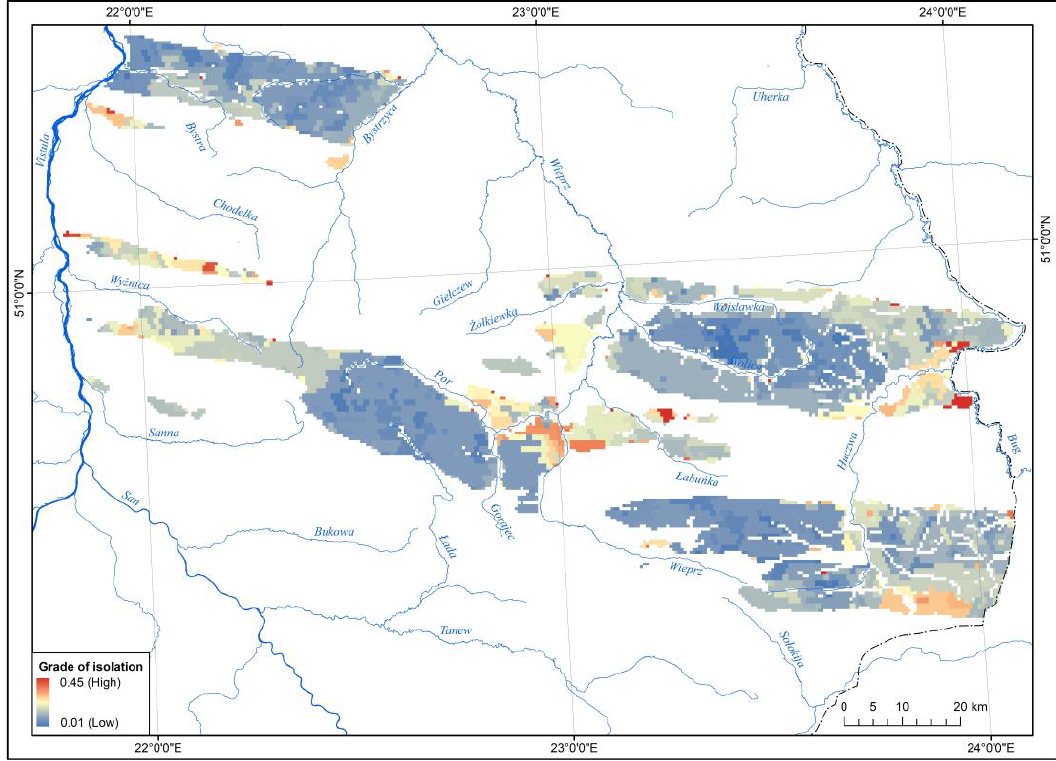
Figure 9. Grade of isolation of unique segments of loess patches.